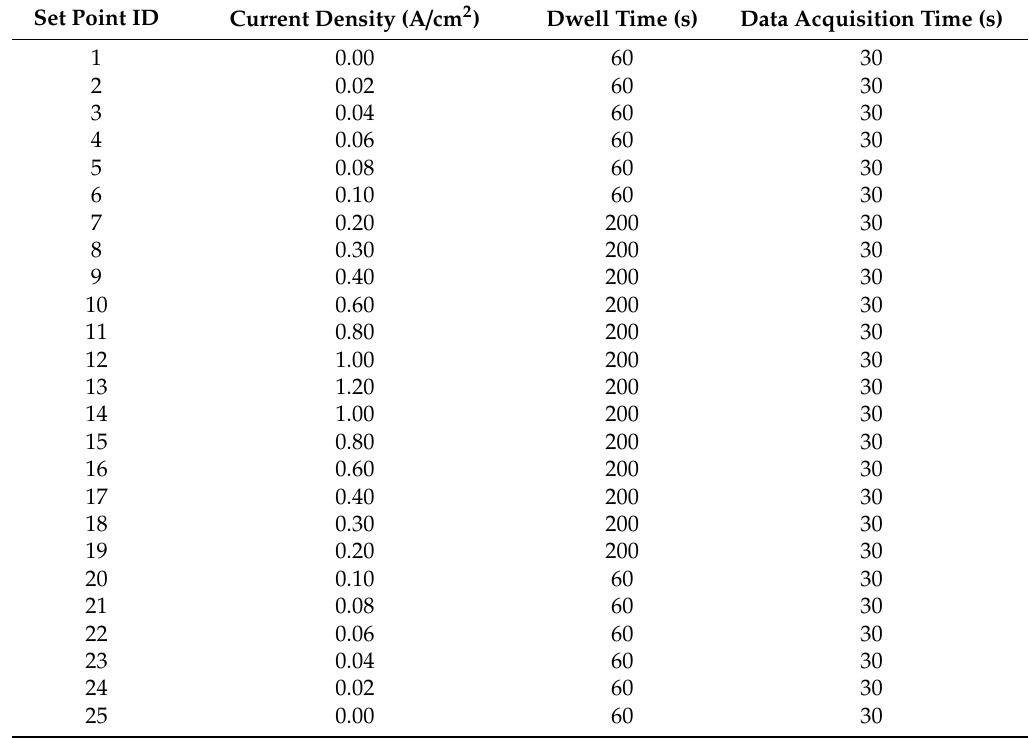
Table A1. Polarization curve set points (forward and backward curves) based on